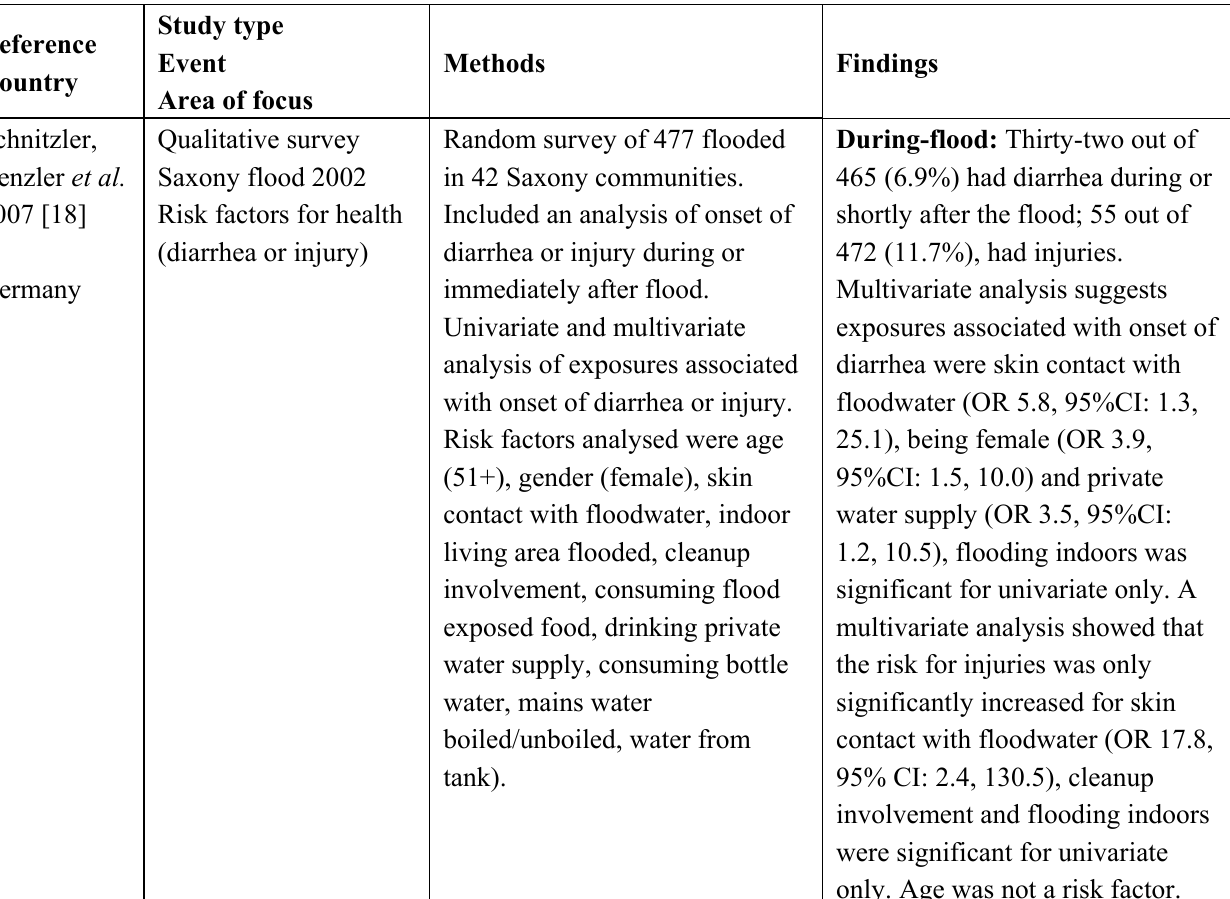
Table A1. Studies addressing research Question 1. What are the demographic or other factors associated with increased risk of morbidity or mortality, among those already